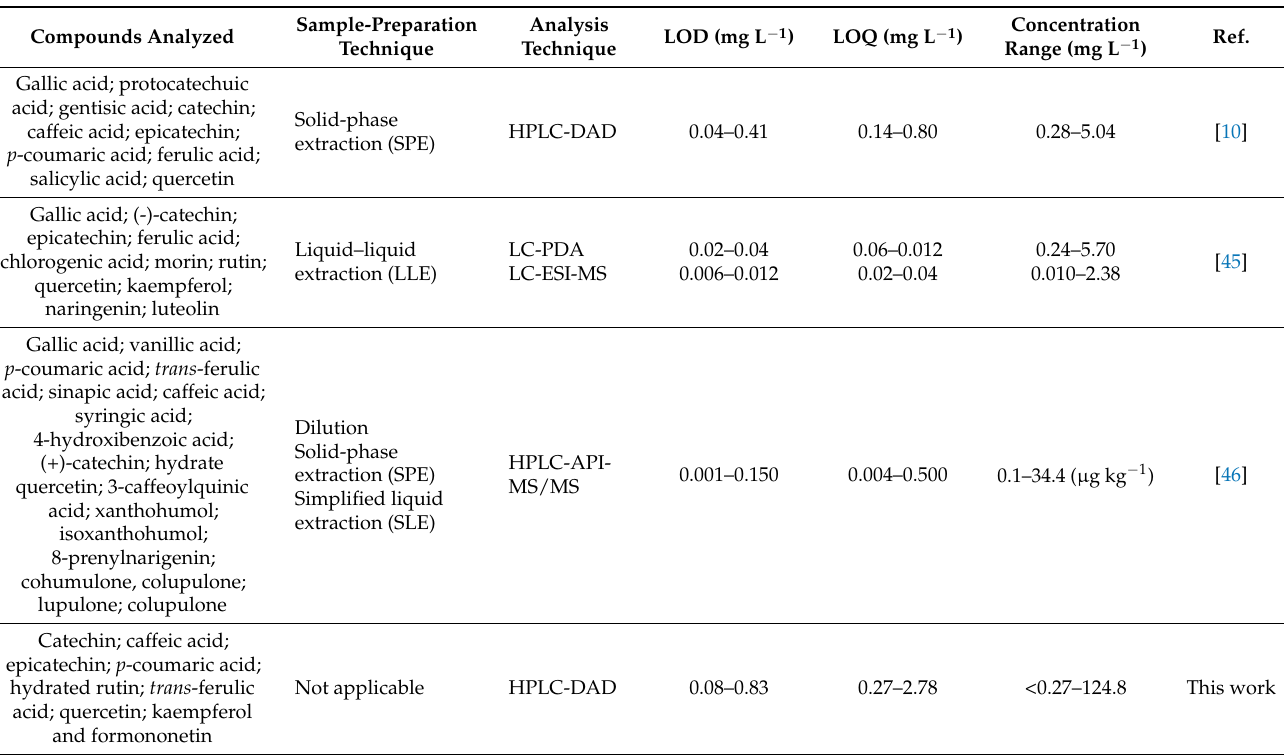
Table 6. Sample-preparation techniques used to analyze phenolic compounds in beers. Sample-Preparation Compounds Analyzed